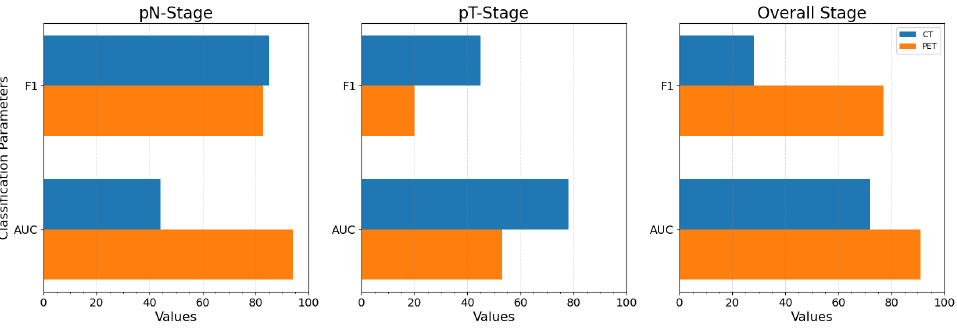
Figure 2. Best results on DS 2 for number of features in [ 5,10,20,50,100 ] in M ALL